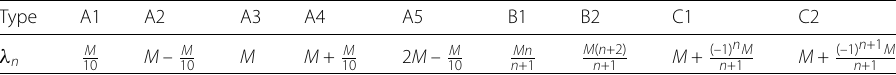
Table 1 The best choice types of testing the parameter λ n for the fast